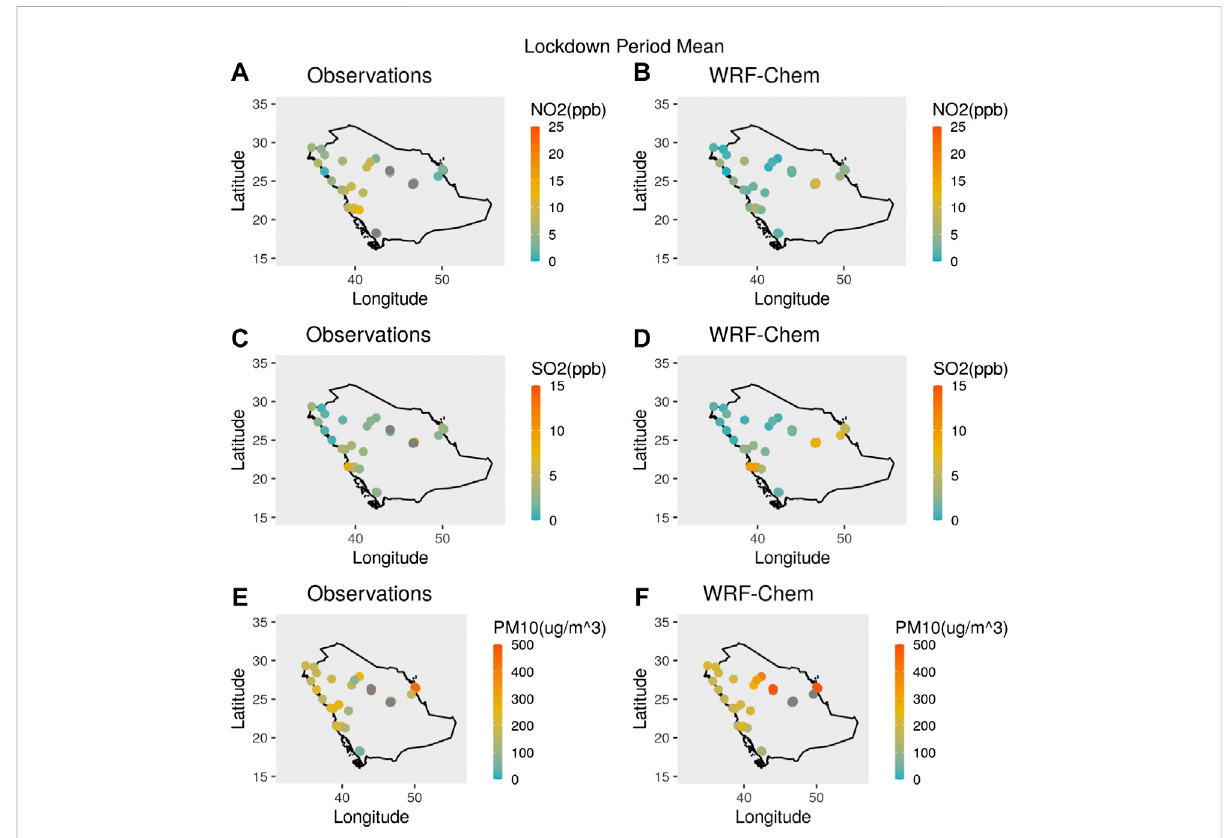
FIGURE 2 Comparison of pollutants NO 2 , SO 2 and PM 10 between ground-based observations (A, C, E) over different regions in KSA and WRF-chem simulations (B, D, F) during